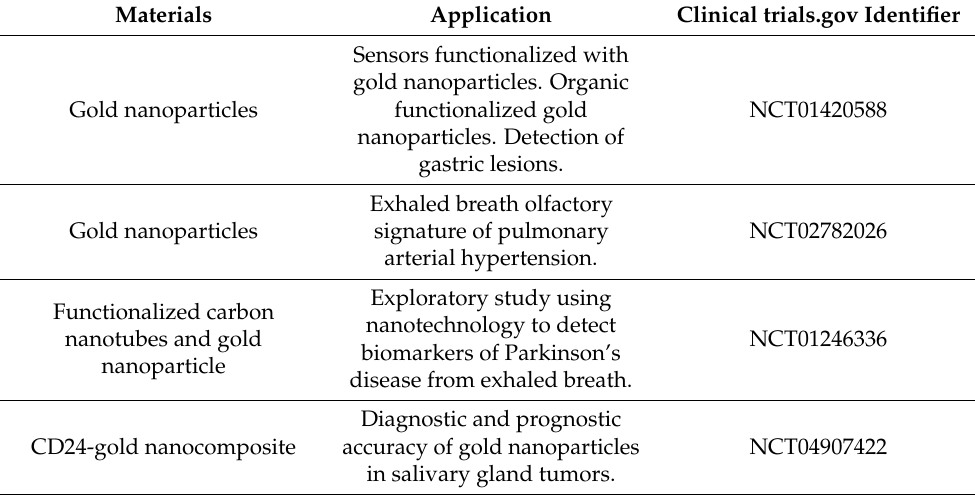
Table 1. Gold nanoparticles clinical trials for imaging and